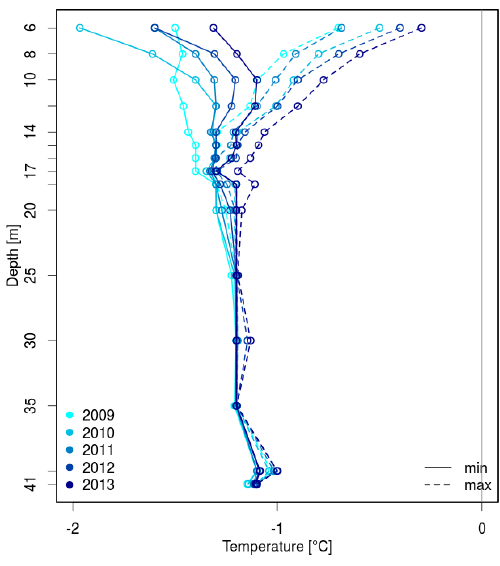
Figure 7. Minimum (solid lines) and maximum (dashed lines) tem- perature profiles in the borehole DP below 6m of depth for the pe- riod 2009–2013.